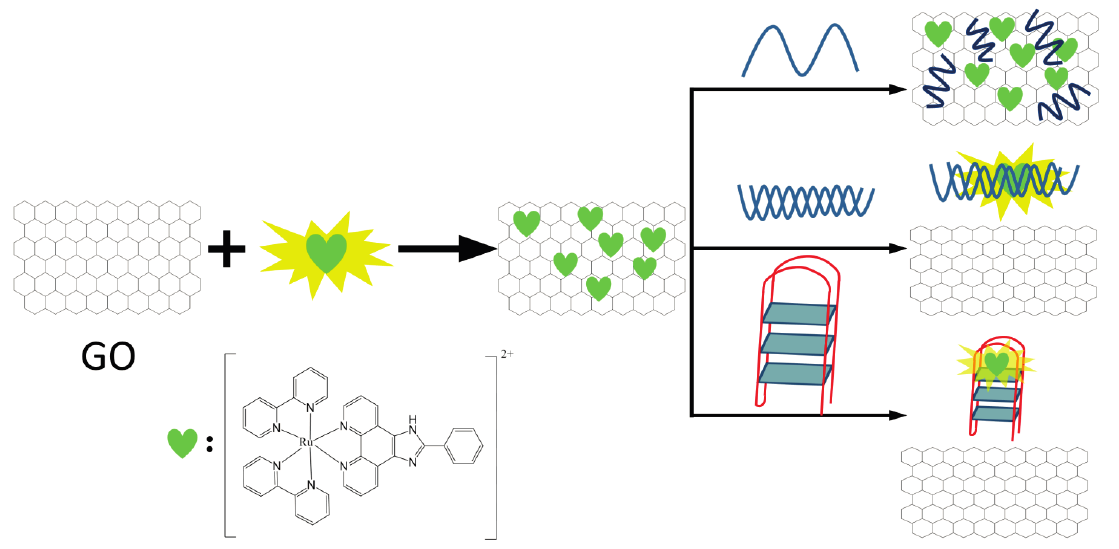
Figure 29. Bioanalysis using Ru[(bpy) permission from ref. [261], copyright (2013)